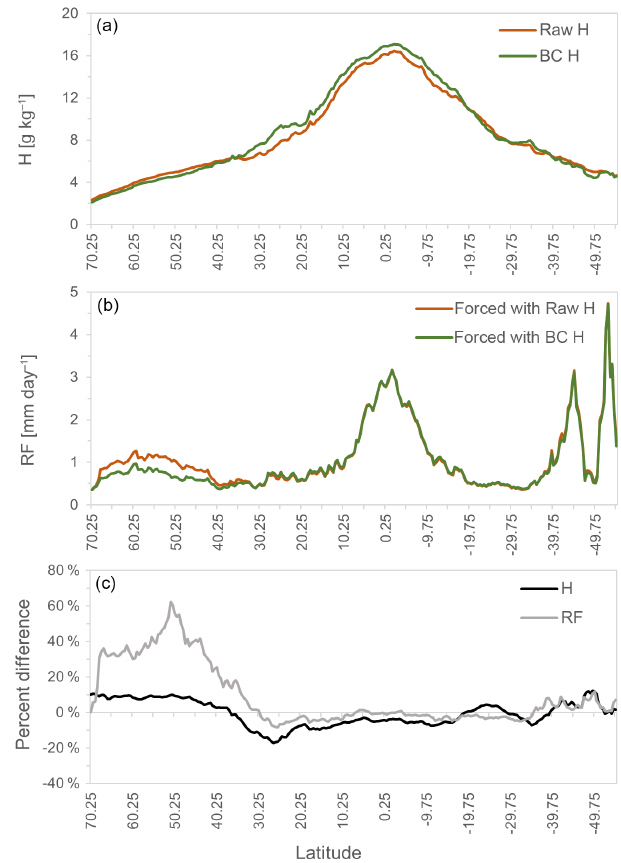
Figure 11. (a) Latitudinal means of raw and bias corrected specific humidity (gkg − 1 ), (b) latitudinal means of JULES’ runoff forced with raw and bias corrected specific humidity (mmday − 1 ), and (c) percent differences of the latitudinal means in (a) H and (b) RF. The latitudinal means are calculated from the 1981–2010